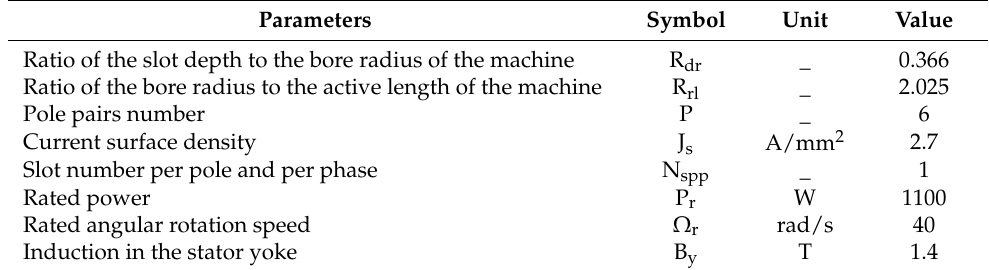
Table 2. Input parameters of an external PMSG dedicated for small wind power applications.